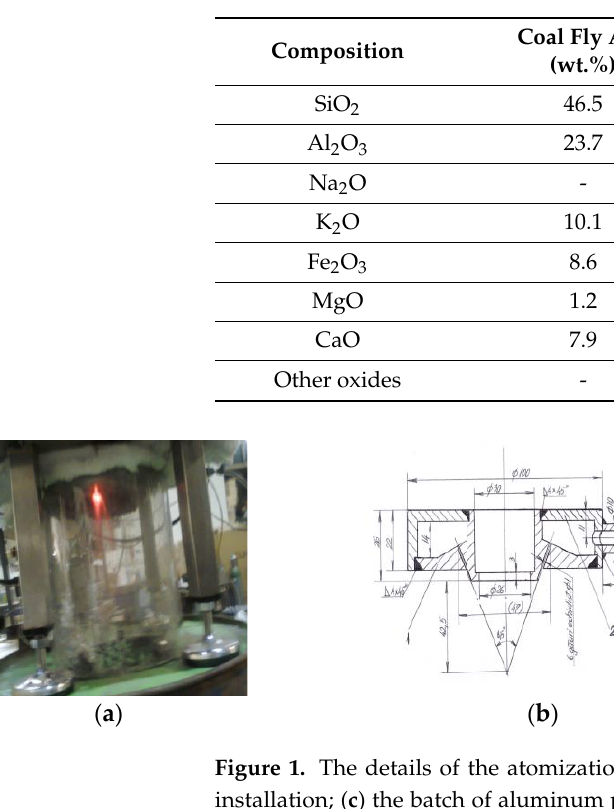
Table 1. The oxide compositions of coal fly ash, perlite, and silica fume.